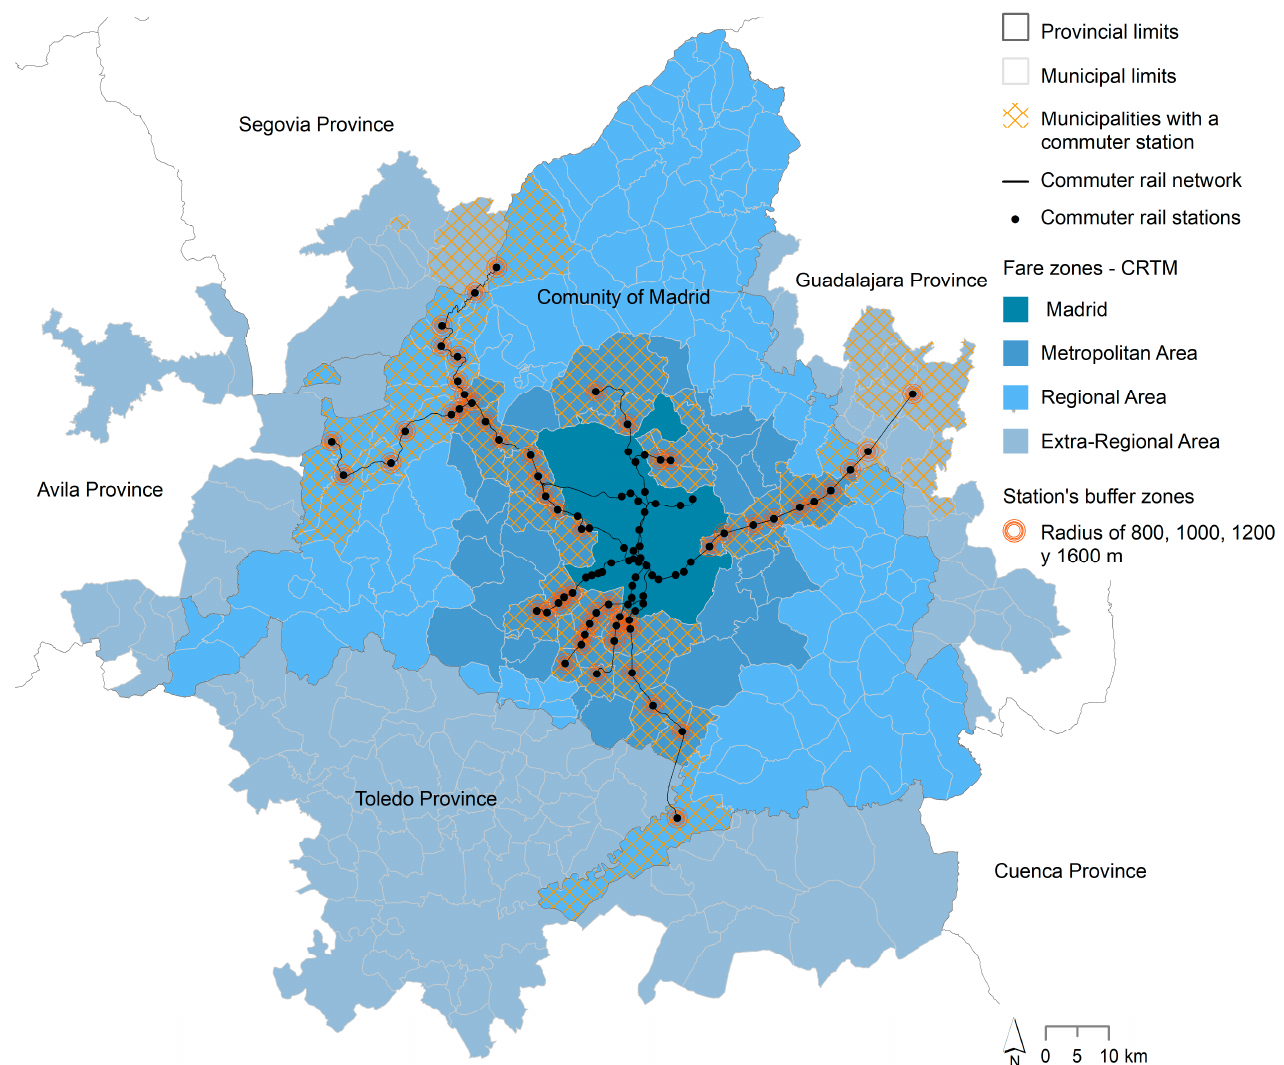
Figure 1. The Madrid urban region and the commuter railway network.